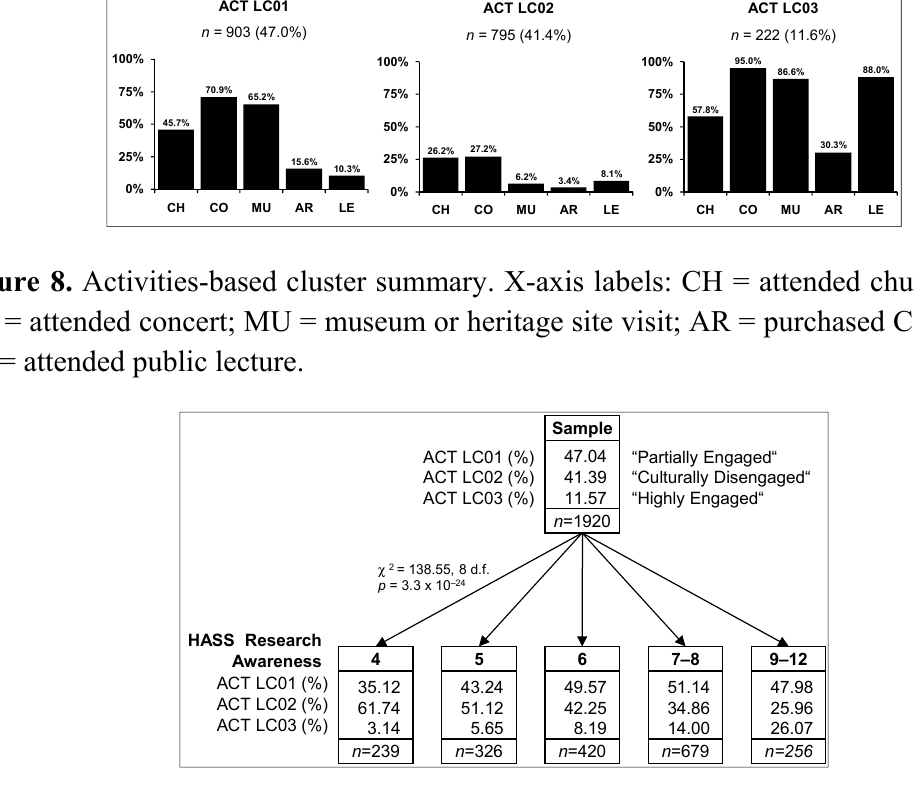
Figure 9. Activities-based segmentation (first level of the CHAID dendogram